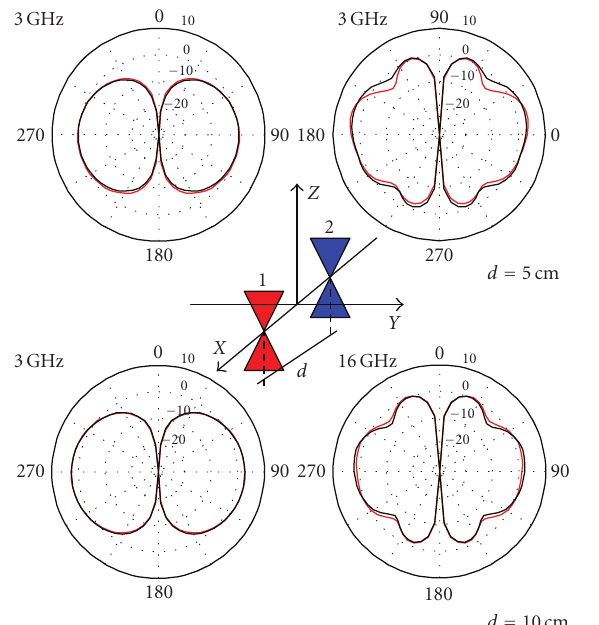
Figure 11: Expected radiation pattern in elevation ( ϕ = 90 ◦ , Z-Y plane) (black line) and SC azimuth-averaged approximation (red line). Antenna 1 is excited; antenna 2 is open circuited.